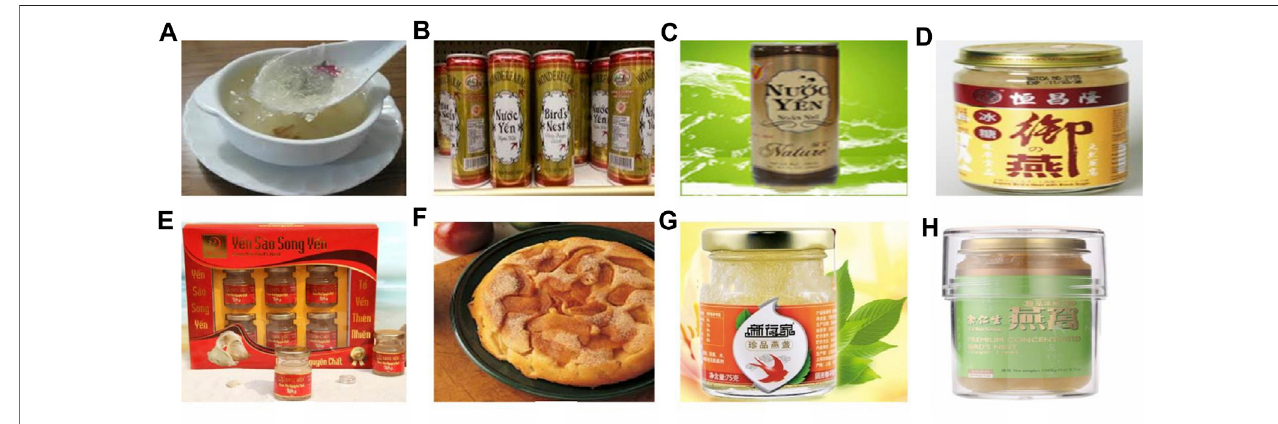
FIGURE 4 | Some of the famous EBN market products based on foods labeled, outlook and, food products. (A) Bird ’ s nest soup, (B) Bird ’ s nest instant energy drink, (C) Vietnam bird ’ s nest powder, (D) Brand new concept EBN powder, (E) Bird ’ s nest drink, (F) Bird ’ s nest pudding recipe, (G) Instant Malaysian cubilose nourishing tonic and (H) Bird ’ s nest granules for supplements. The image is adapted from (Yen, 2015).